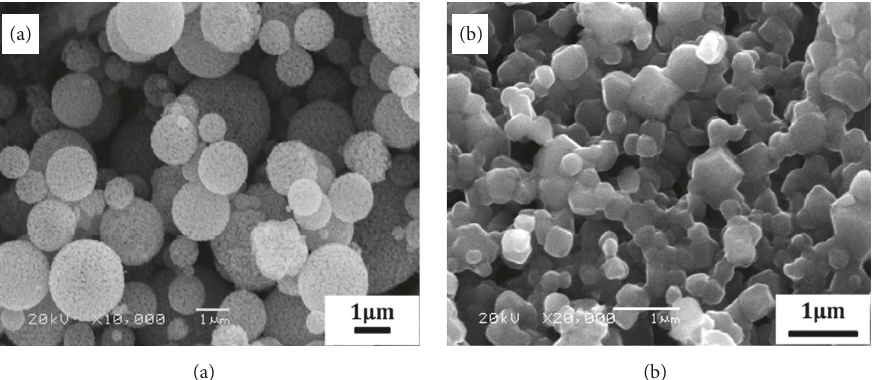
Figure 4: SEM of the (a) precursor powder and (b) NCM622 cathode powder prepared by ultrasonic spray drying [26]. Copyright: Materials Letters, 2015.